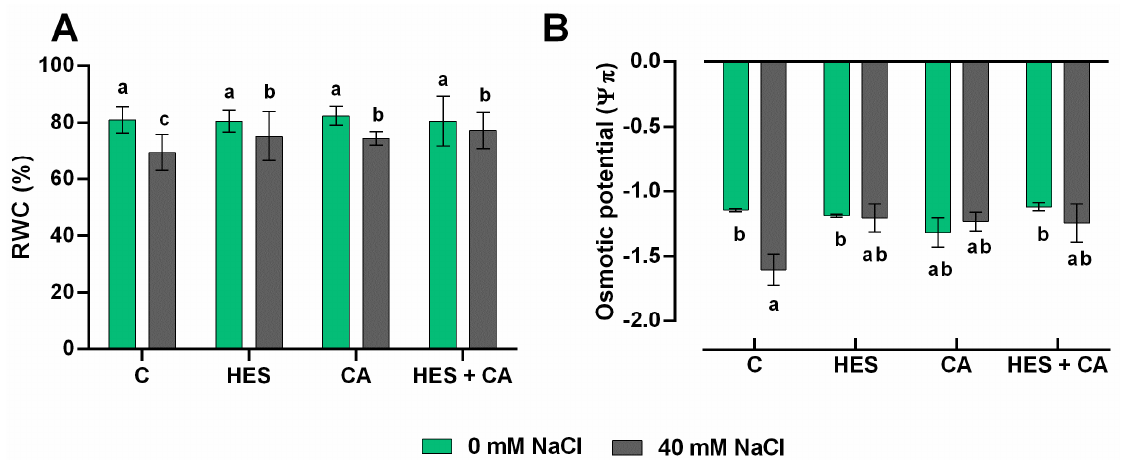
Figure 1. ( A ) Relative water content (RWC) and ( B ) leaf osmotic potential ( Ψ π ) of lettuce after 10 days of treatments, the values are expressed as mean percentage ± standard deviation of four independent replicates. The lettuce plants were treated with: control no treated (C), 100 μ M hesperidin (HES), 50 μ M chlorogenic acid (CA), 100 μ M HES + 50 μ M CA. Treatments were performed under both salt (40 mM NaCl) and non-salt (0 mM NaCl) stress. The statistical significance has been tested by a one-way ANOVA test with Tukey post-test multiple comparisons ( p -value < 0.05), and significant differences between treatments are indicated by lowercase letters above each bar.